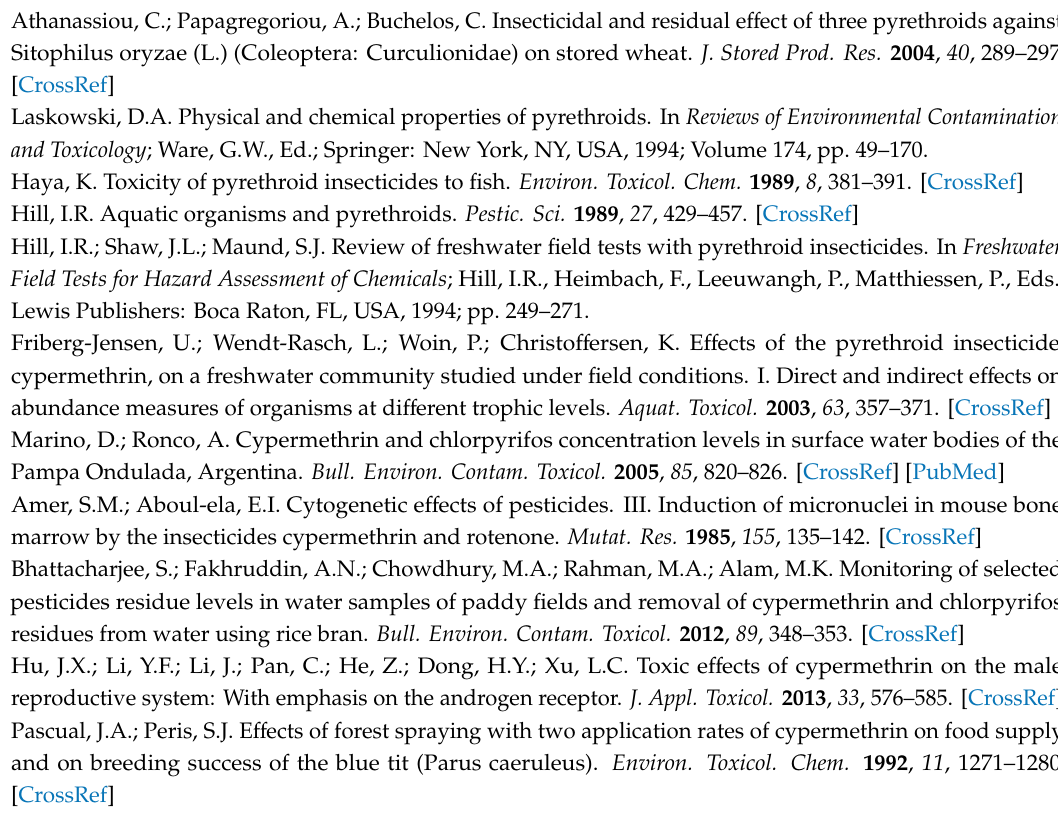
s1, Table S1: Pseudo-first-order and pseudo-second-order model parameters, Table S2: Langmuir isotherm constants obtained for the cypermethrin adsorption, Table S3: Freundlich isotherm constants obtained for the cypermethrin